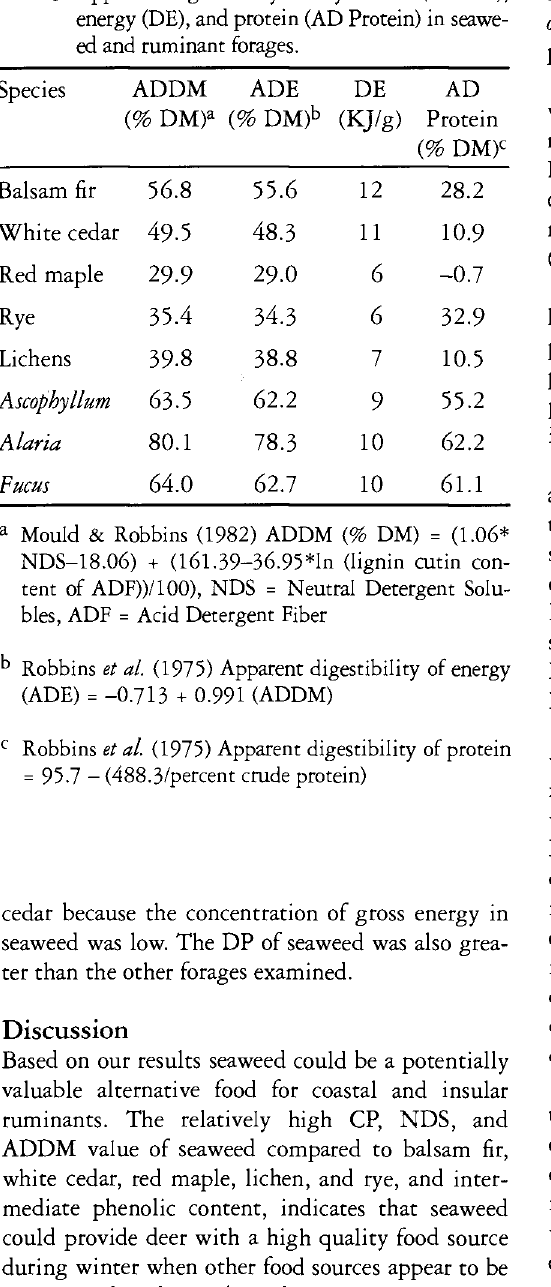
Table 3. Apparent digestibility of dry-matter (ADDM), energy (DE), and protein (AD Protein) in seawe ed and ruminant